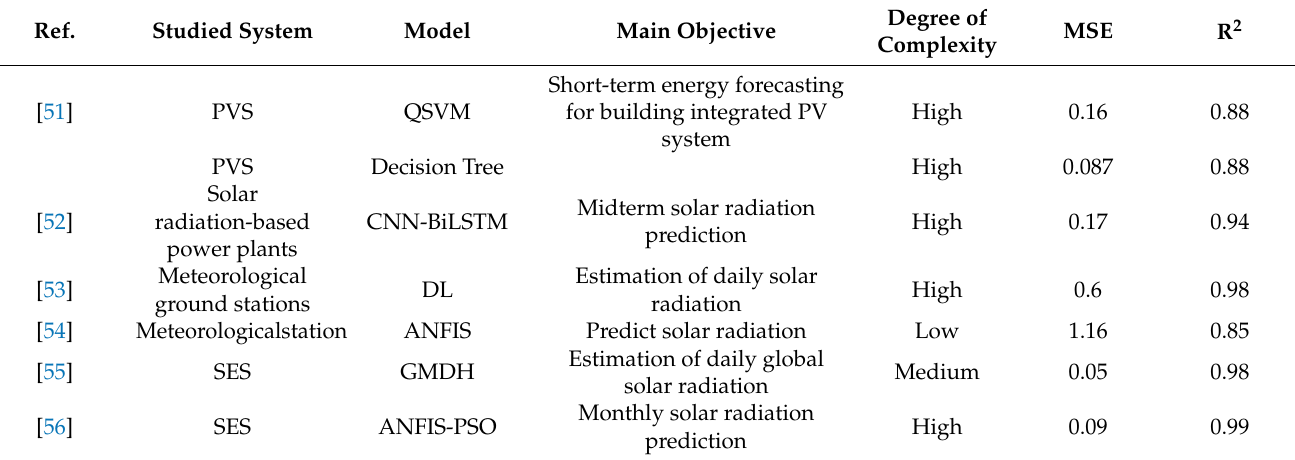
Table 3. Comparative